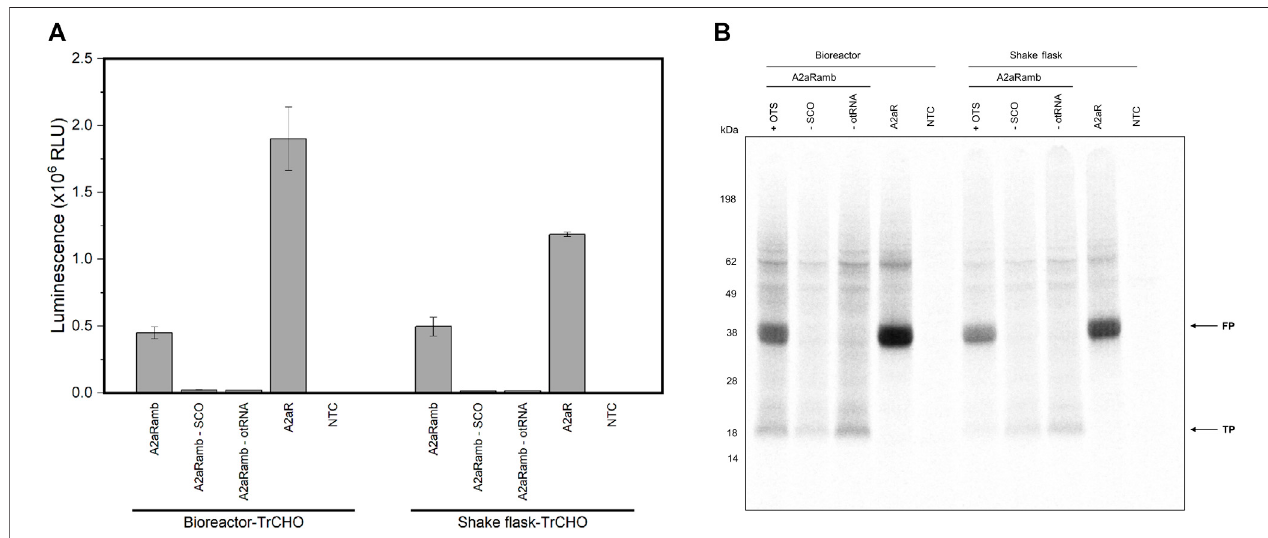
FIGURE 6 | CFPS based on transiently transfected CHO cells expressing PylRS-AF. (A) Luciferase assay of cell-free synthesized A2aRamb and A2aR constructs based on transiently transfected CHO cells expressing the PylRS-AF. Samples with a plus indicate the addition of the particular orthogonal component, while a minus indicatestheabsenceoftheorthogonalcomponent.Experimentswereperformedintechnicaltriplicatesandbarsrepresentthestandarddeviation. (B) Autoradiography of electrophoretically separated proteins corresponding to CFPS shown in (A) . FP: Full-length protein, TP: Truncated protein, NTC: No-template control, SCO: Strained cyclooctyne, otRNA: Orthogonal tRNA, OTS: Orthogonal translation system, TrCHO: Transiently transfected CHO